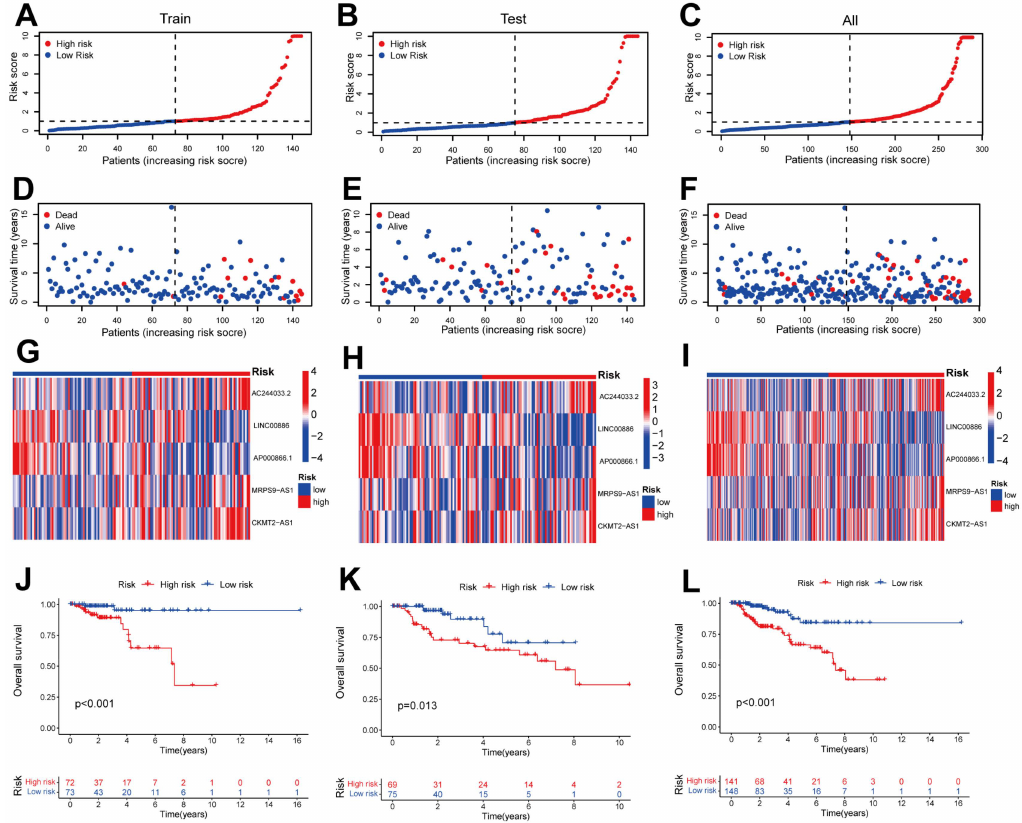
Figure 3. Evaluating and validating for the prognostic value of CRLs in testing, training and all sets. ( A – C ) Patient distribution with increasing risk scores. ( D – F ) Survival time of patients and risk scores. ( G – I ) Heatmaps of 5 CRLs. ( J – L ) Kaplan–Meier (KM) survival analysis of overall survival (OS) of pRCC patients between high- and low-risk